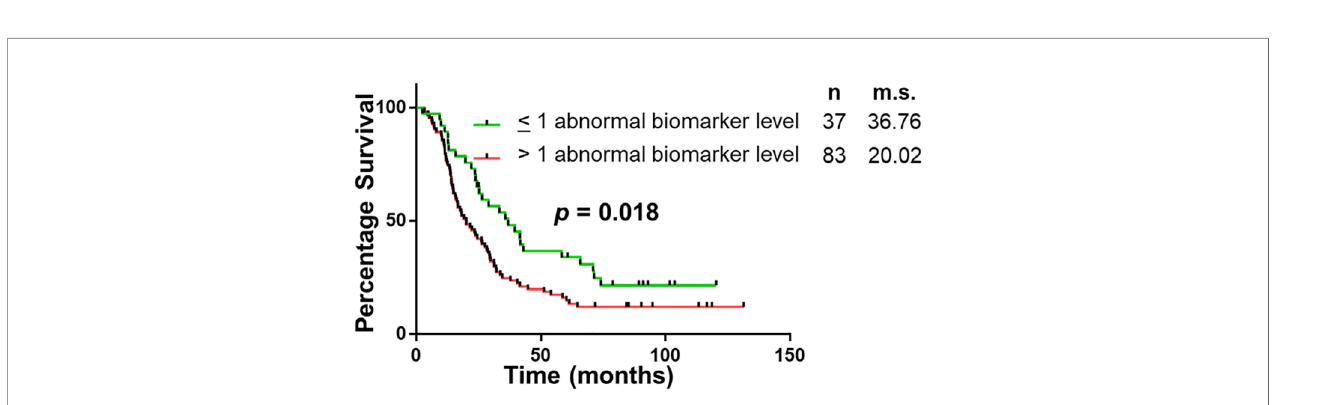
FIGURE 3 | Univariable Survival Analysis of Biomarker Panel. Kaplan Meier survival curves comparing patients with abnormal biomarker levels of one or less biomarker and patients with abnormal biomarker levels of two or more biomarkers. n, number of patients; m.s., median survival in